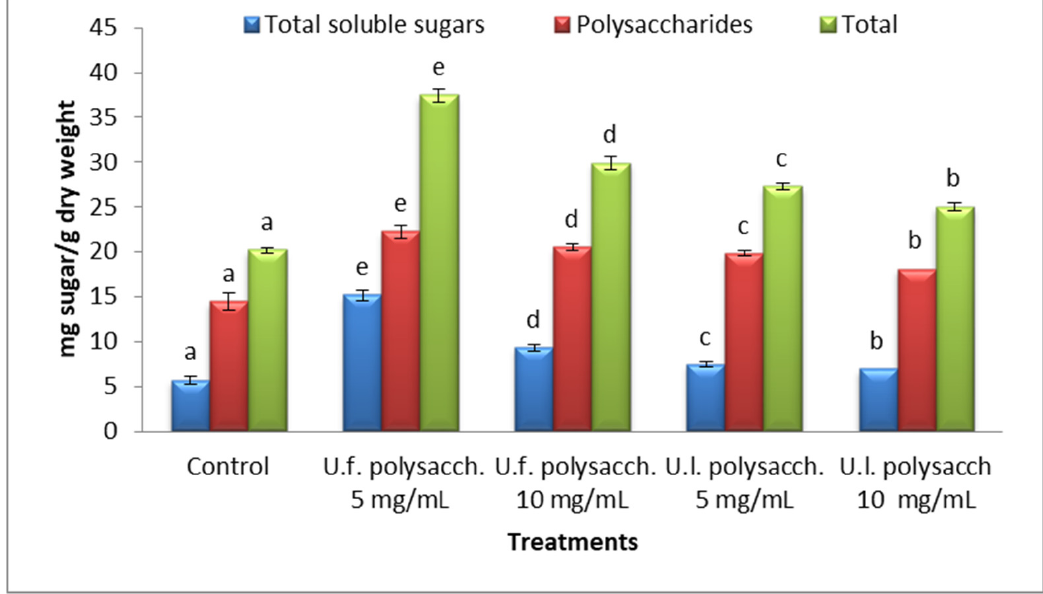
Figure 10. Effect of seed priming with different concentrations of soluble polysaccharides on the carbohydrate contents of growing Zea mays seeds. The bars represent the standard error (different letters denote the significant values among the treatments with the same parameter). U.f., Ulva fasciata; U.l., Ulva lactuca .